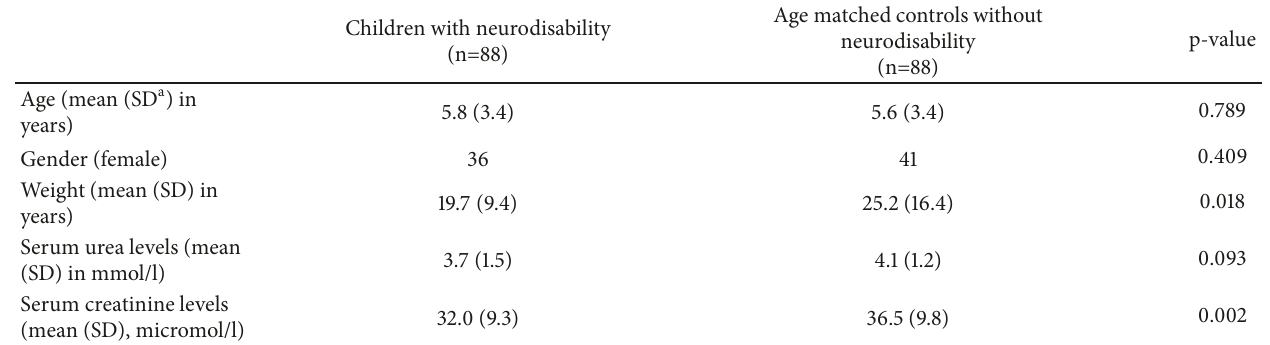
Table 1: Personal characteristics, urea, and creatinine levels in children with and without neurodisability. Children with neurodisability